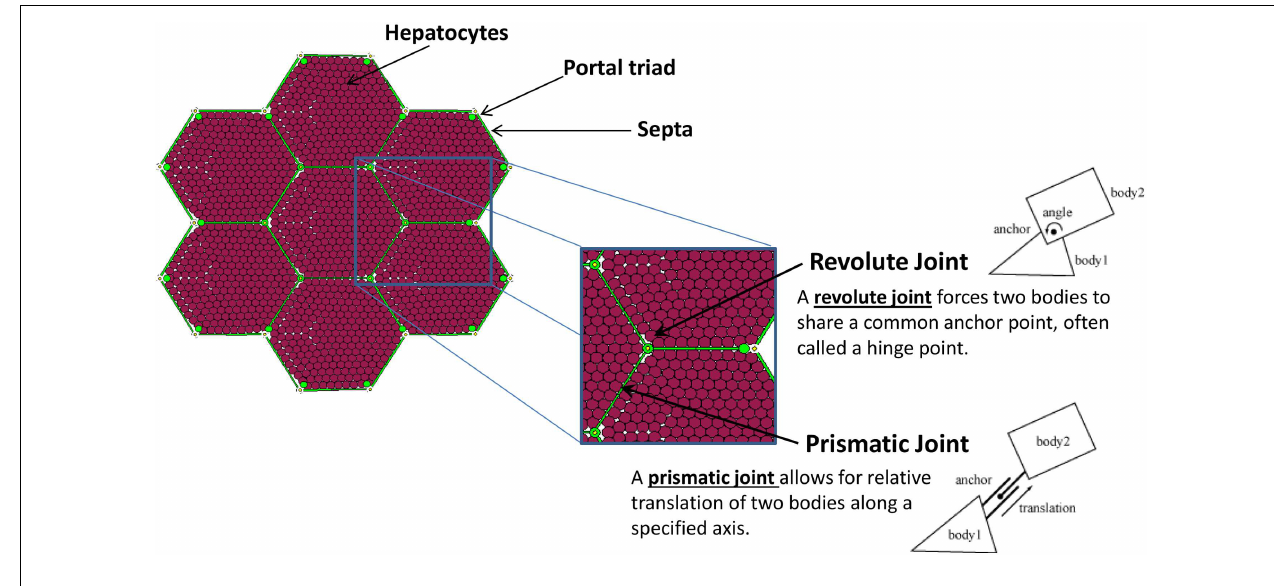
FIGURE 1 |The structural elements comprising the tissue framework